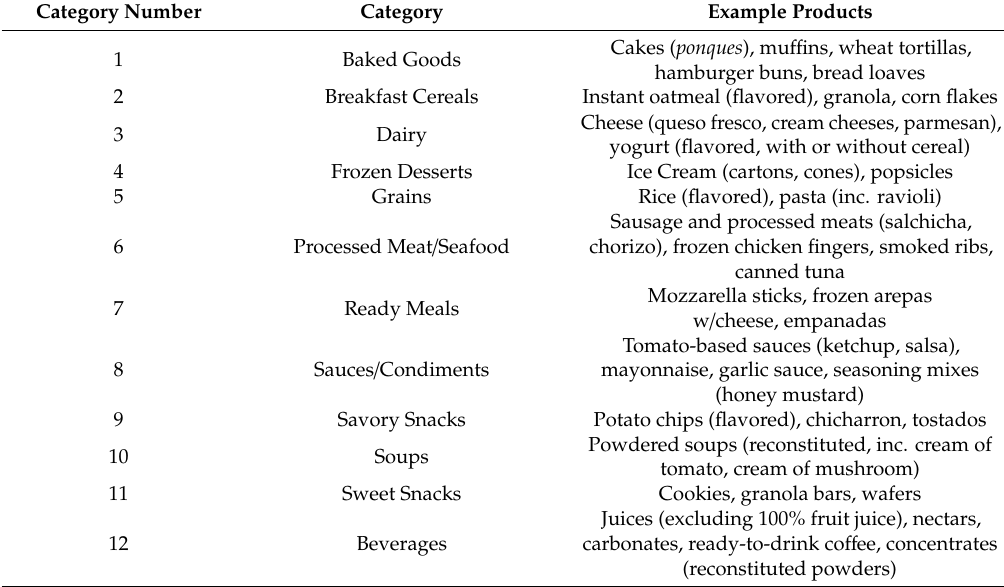
Table A3. Example Products by